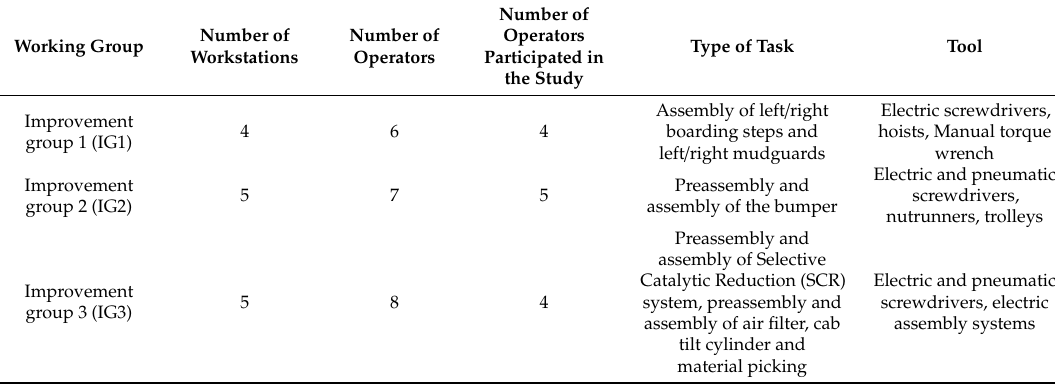
Table 1. The characteristics of the Improvement Groups (IG), the number of workstations and tools, operators, and the type of